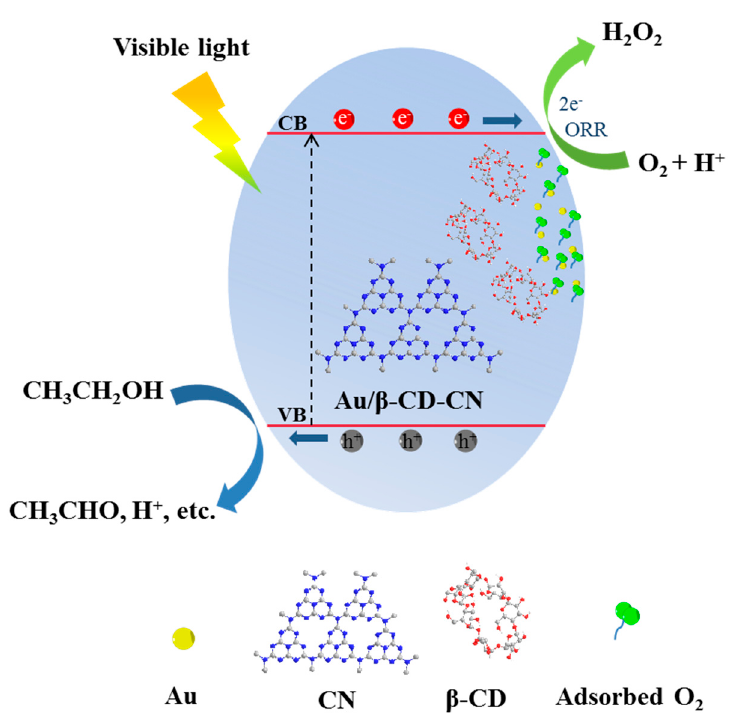
Figure 9. Proposed mechanism of photocatalytic H 2 O 2 production over Au / β -CD-CN composite under visible light.